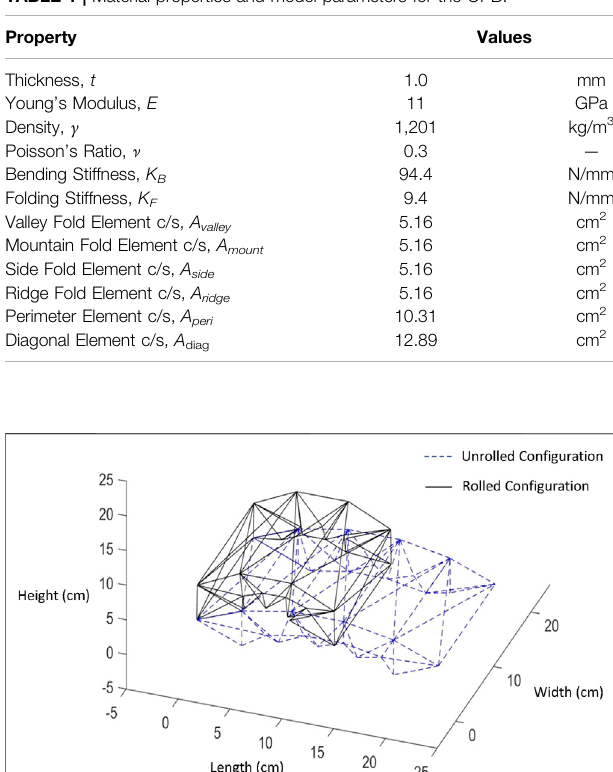
TABLE 1 | Material properties and model parameters for the OPB.